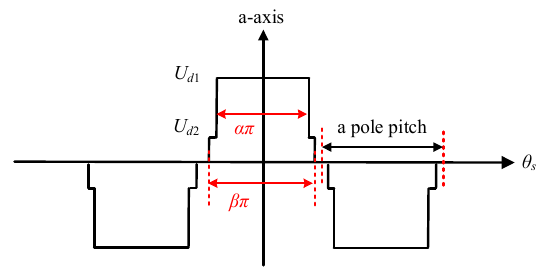
Figure 8. Magnetic potential distribution in the d ‐ axis.